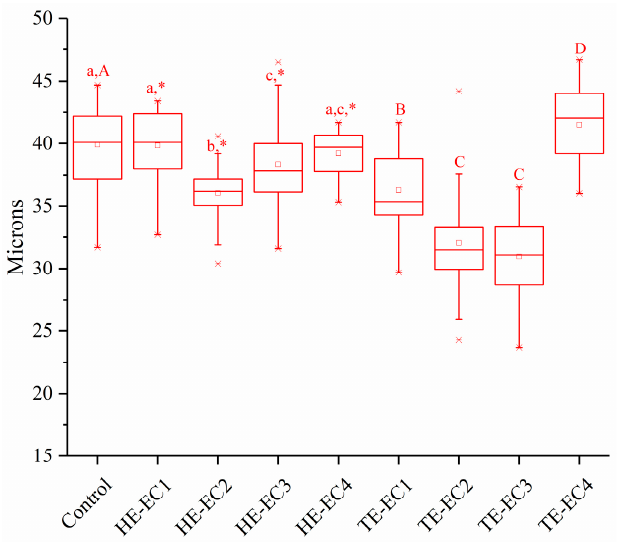
Figure 3. Wear depth mean values (micron) of experimental composite resins after 15,000 cycles of the 2-body wear test. The same lower letters indicate that there is no significant difference in wear depth between experimental composite resins with different weight fractions of HE-Phene in the resin matrix. The same upper letters indicate that there is no significant difference in wear depth between experimental composite resins with different weight fractions of TE-Phene in the resin matrix. The asterisk * indicates the statistical differences between composites with different Phene like monomers at the same mass fraction in resin matrix.